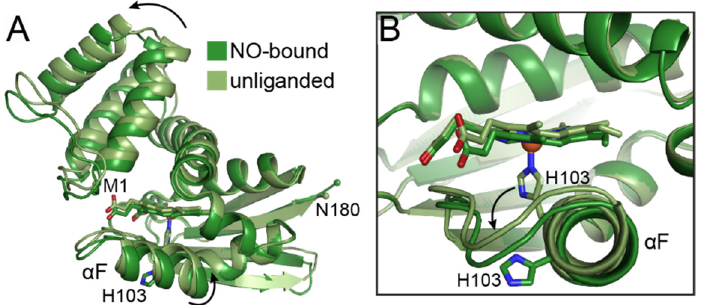
Figure 2. NO binding induces conformational changes in So H-NOX. ( A ) Overall structures of So H-NOX in the unliganded (light green, PDB ID 4U99 [45]) and NO-bound (dark green, PDB ID 4U9B [45]) states. NO binding induces rotation of the α F helix and a shift of the distal subdomain away from the heme binding pocket, as indicated by the black arrows. Structures were aligned by least squares fitting by the β -sheet region of the proximal subdomain (r.m.s.d. = 0.55 Å for 62 C α atoms). ( B ) Zoomed in view of the heme cofactor showing cleavage of the iron–His103 bond as viewed down the axis of the α F helix. Protein is shown in ribbon representation with the heme in sticks and the iron center in spheres. His103 is shown in sticks. Sticks and spheres are colored with C in green, N in blue, O in red, and Fe in orange. The N- and C-termini are labeled and shown as small spheres in panel A.